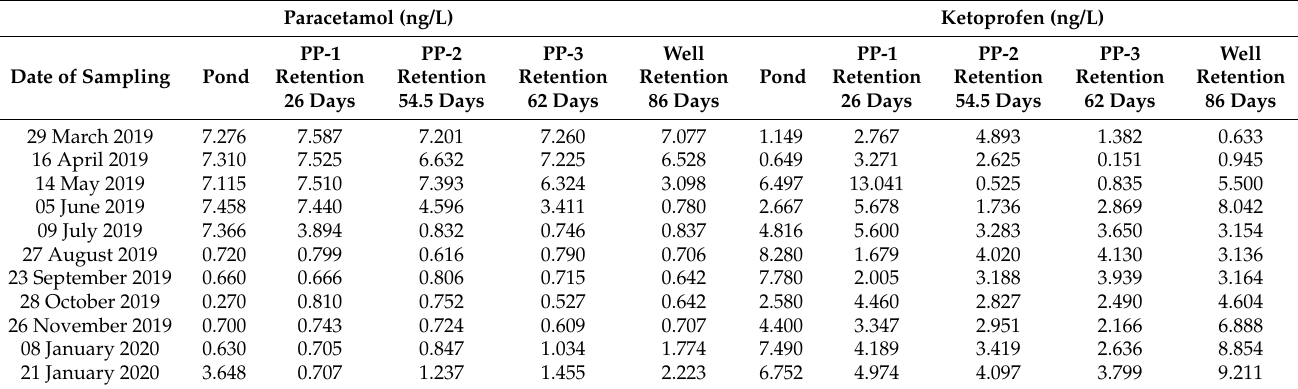
Table 3. Approximated concentrations of tested NSAID in water samples after the time of retention in the ground. Paracetamol